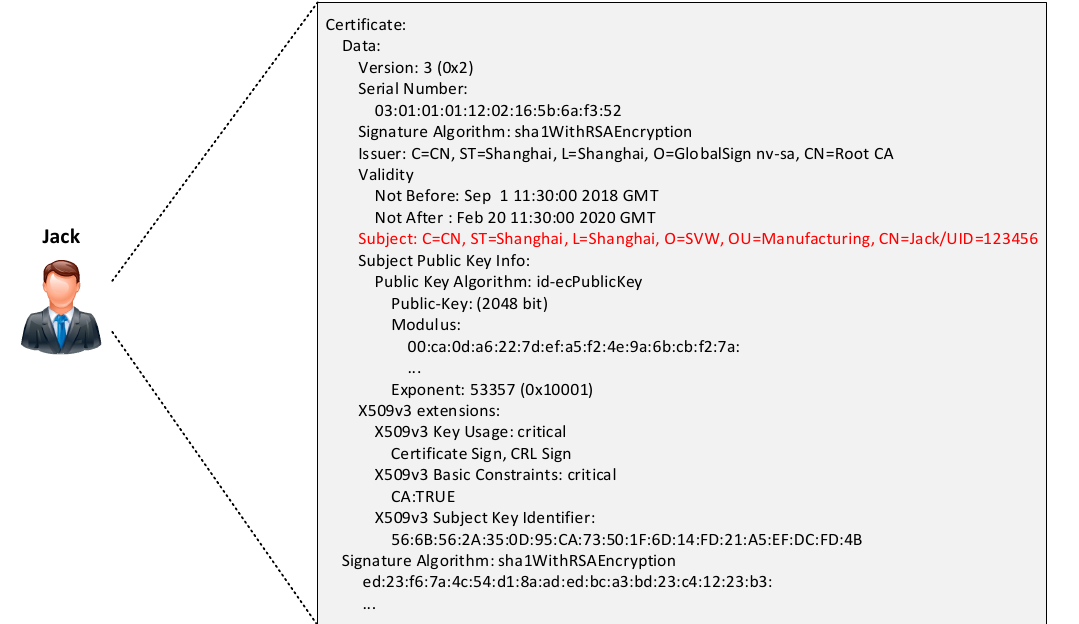
Figure 13. Sample participant certificate issued by Fabric-CA using